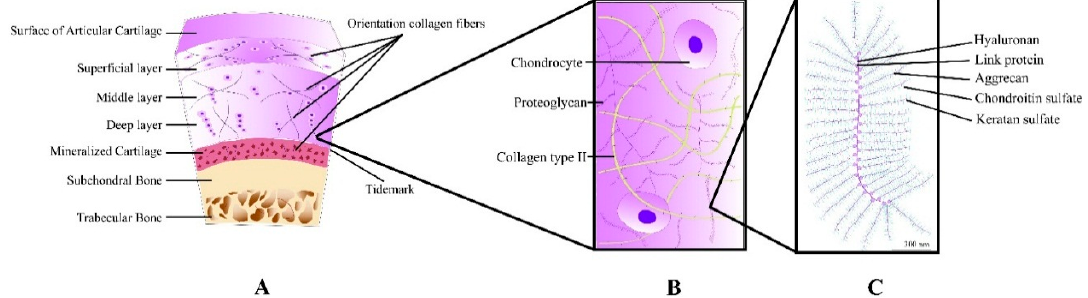
Figure 2. Schematic representation of articular cartilage and its contents: ( A ) Normal view of cartilage as osteochondral unit with specific zones; ( B ) Magnification of middle zone and its content; ( C ) Representation of typical proteoglycan structure. Reprinted with permission from Marjolein M. J. Caron [41]. Chondrocytes originate from MSCs and are able to undergo several stages of